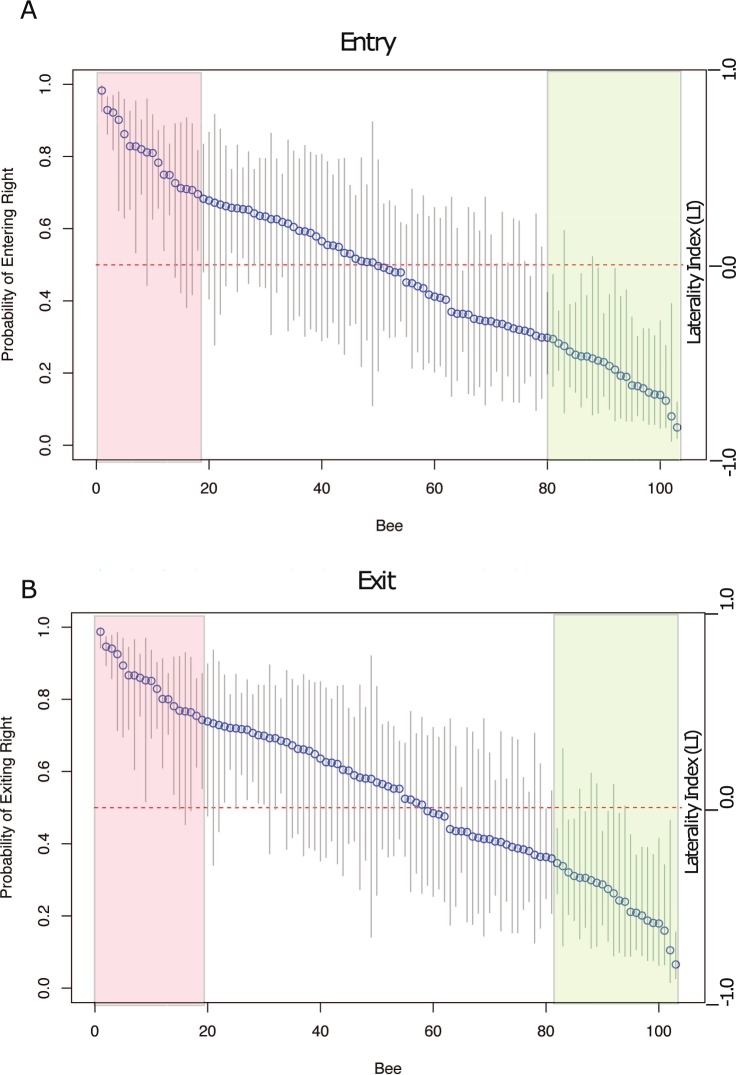
Equal apertures: Probability of choosing the right-hand aperture for individual bees for (A) the Entry condition, and (B) the Exit condition. Blue circles represent mean values, and grey vertical lines show 95% confidence intervals. The numbers on the horizontal axis represent individual bees, ranked according to their preference for the right-hand aperture. The horizontal dashed red line represents a random choice probability of 0.5. The red and green areas highlight bees with significant right and left biases, respectively.